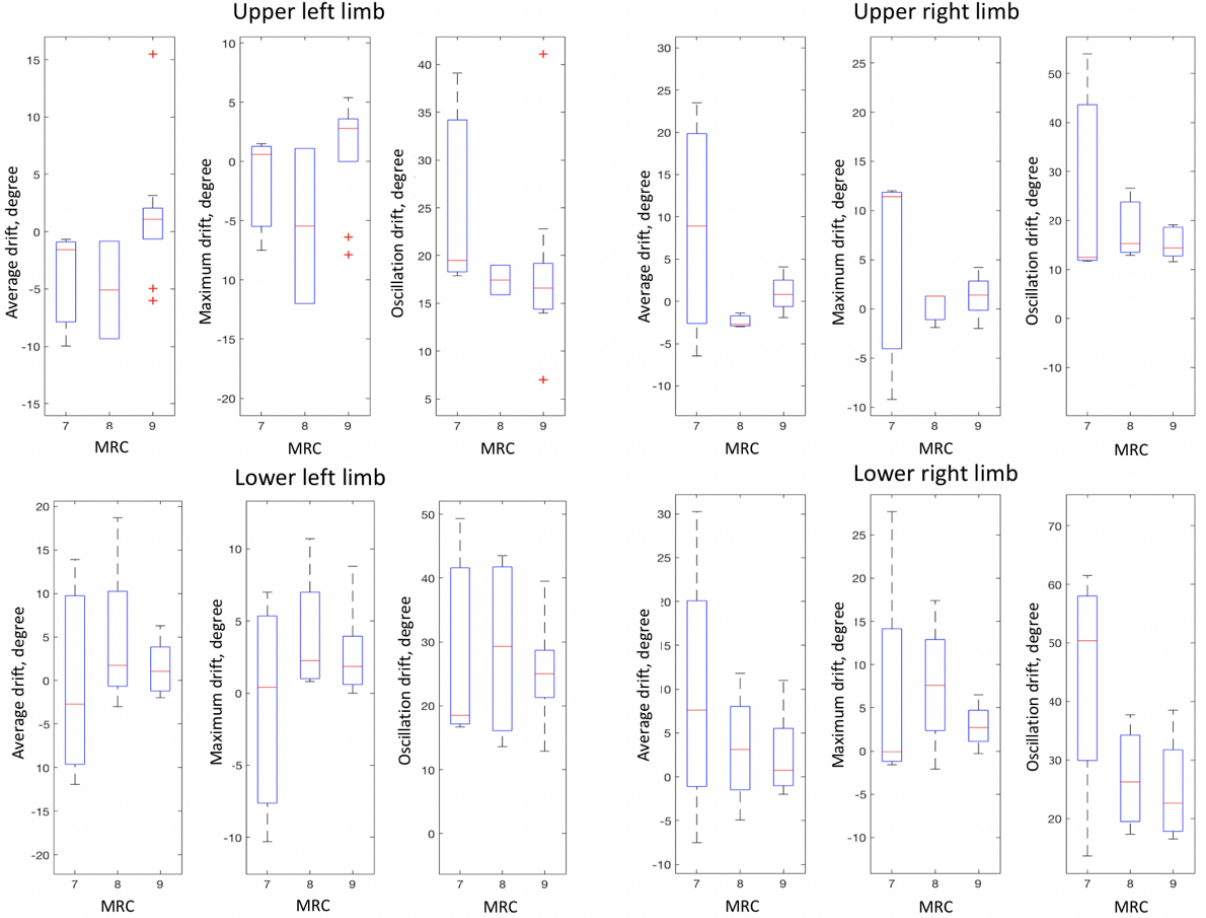
Figure 7. Statistical plots of 4-limb features of MRC grades. MRC: Medical Research